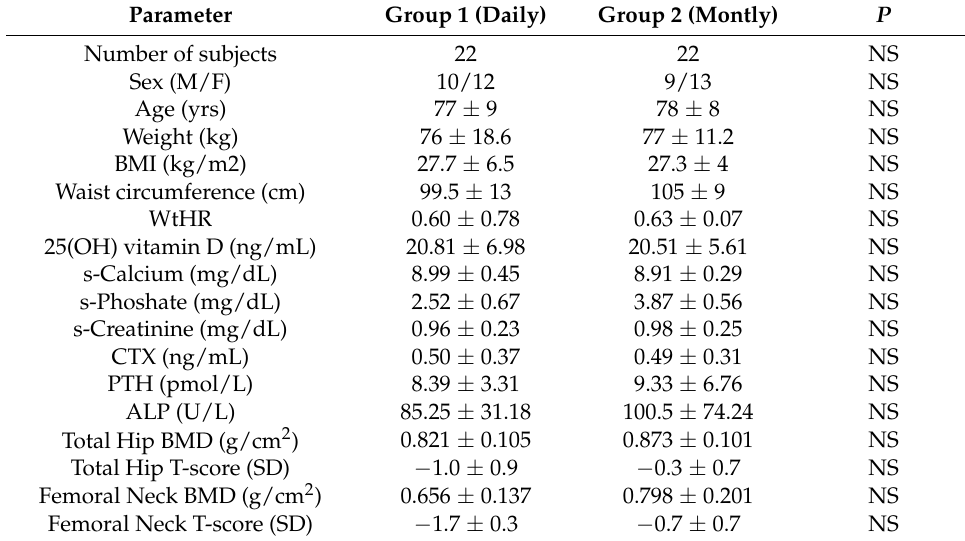
Table 1. Anthropometric, densitometric, and biochemical variables of the study population undergoing the two regimens of